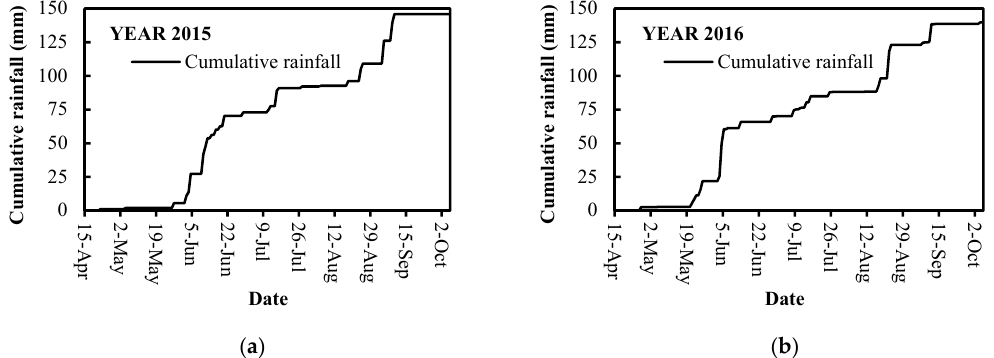
Figure 5. Cumulative rainfall in 2015 and 2016: ( a ) cumulative rainfall from 15 April to 5 October in 2015; ( b ) cumulative rainfall from 15 April to 5 October in 2016.